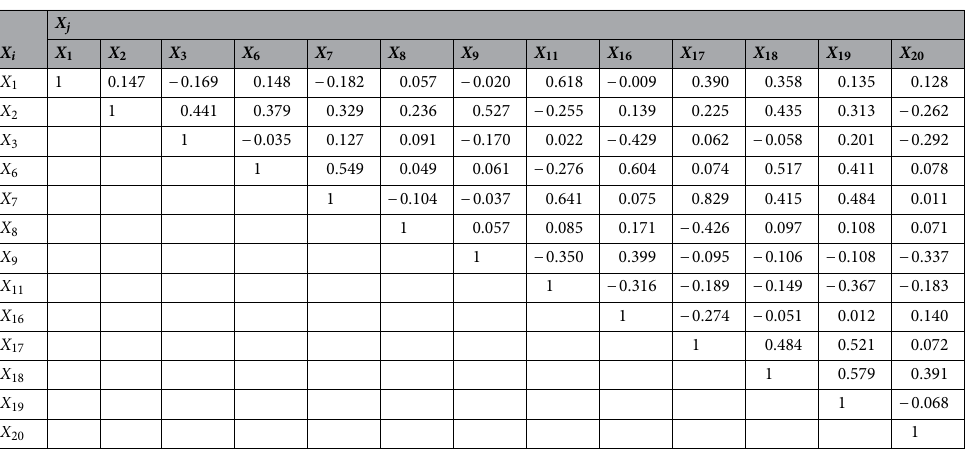
Table 14. Second-order interaction effect index value between